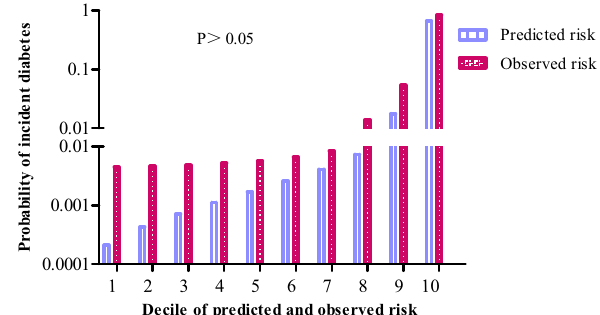
Figure 5. Comparison between predicted and observed 3-year incidence of deciles of predicted diabetes risk score for the training cohort in the nomogram.